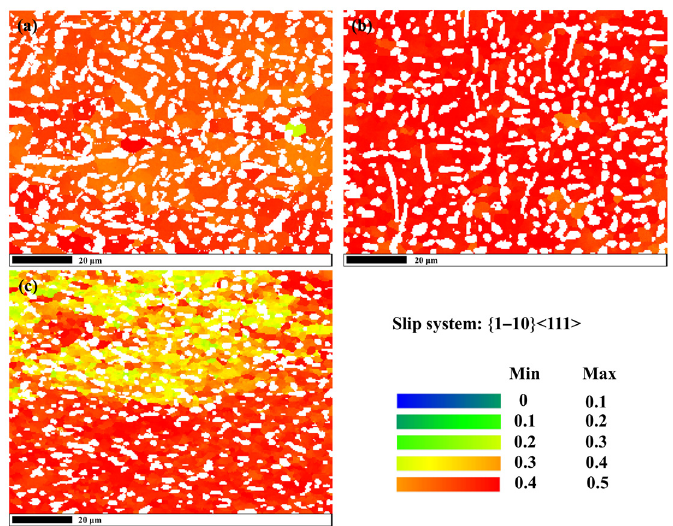
Figure 12. Schmid factor maps for the {1 − 10} <111> slip system of TB6 titanium alloy deformed at 740 °C and different strain rates: ( a ) 0.0001 s − 1 ; ( b ) 0.01 s − 1 ; ( c ) 1 s − 1 .